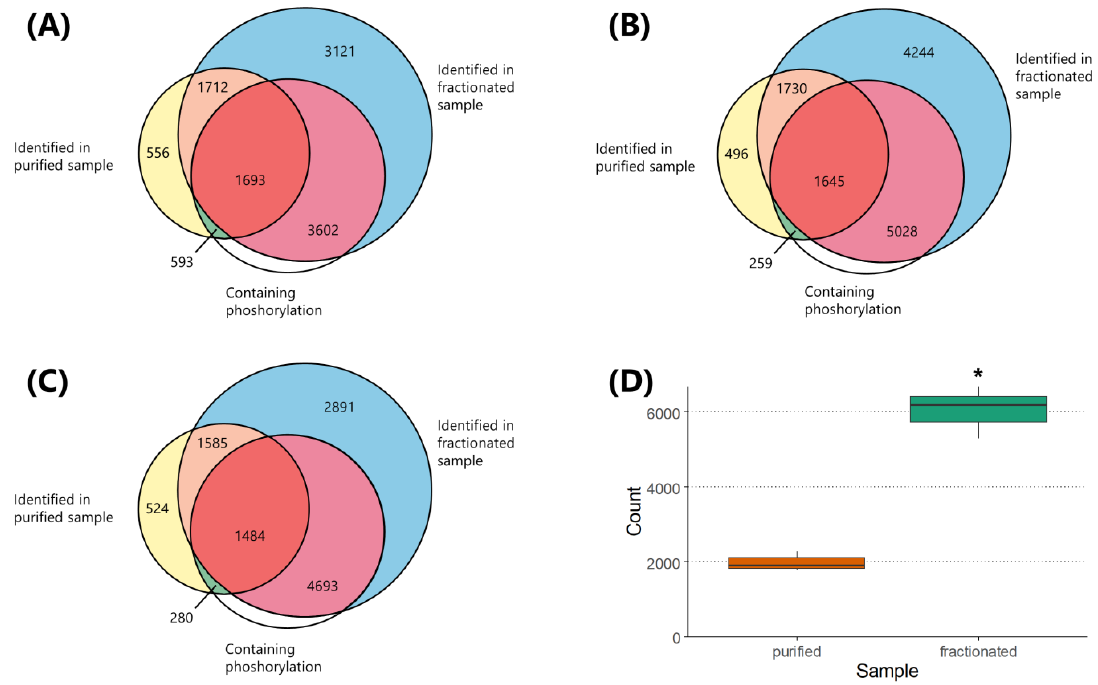
Figure 4. Overview of the peptides identified by the LC–MS / MS analysis. Data from experiments performed within three biological replicates from the H1299 cell line are shown. Venn diagrams of all peptides identified in the first ( A ), second ( B ), and third ( C ) replicate of the purified and fractionated sample with the included number of phosphorylated and non-phosphorylated peptides, respectively. Statistical comparison between phosphopeptides identified in the purified sample and the fractionated sample is visualized as a boxplot of all three replicates ( D ). * Significant difference compared to purified sample ( p -value ≤ 0.0 05).